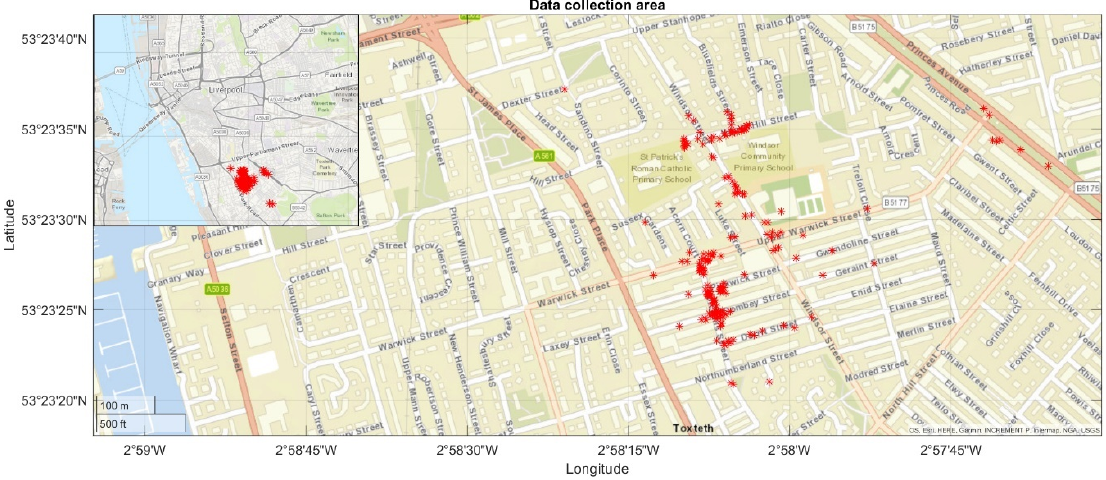
Figure 2. Data collection